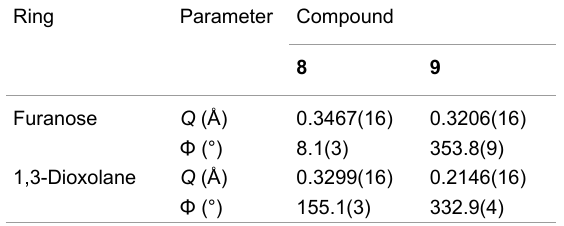
Table 5: Puckering parameters a for the five-membered furanose ring and the five-membered 1,3-dioxolane ring in compounds 8 and 9 . Ring